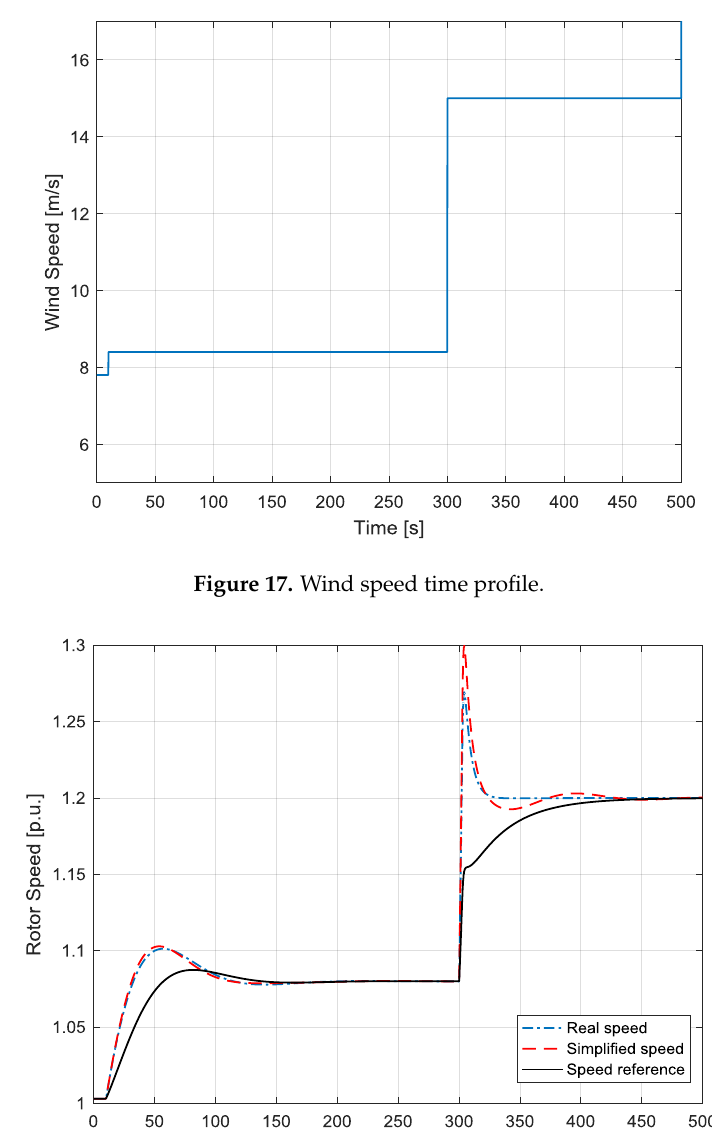
Table 4. Controller parameters. Regulator